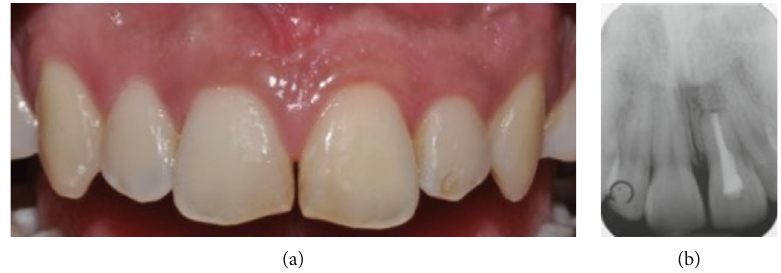
Figure 8: (a) Clinical and (b) radiographic view 4 years after the surgical therapy.